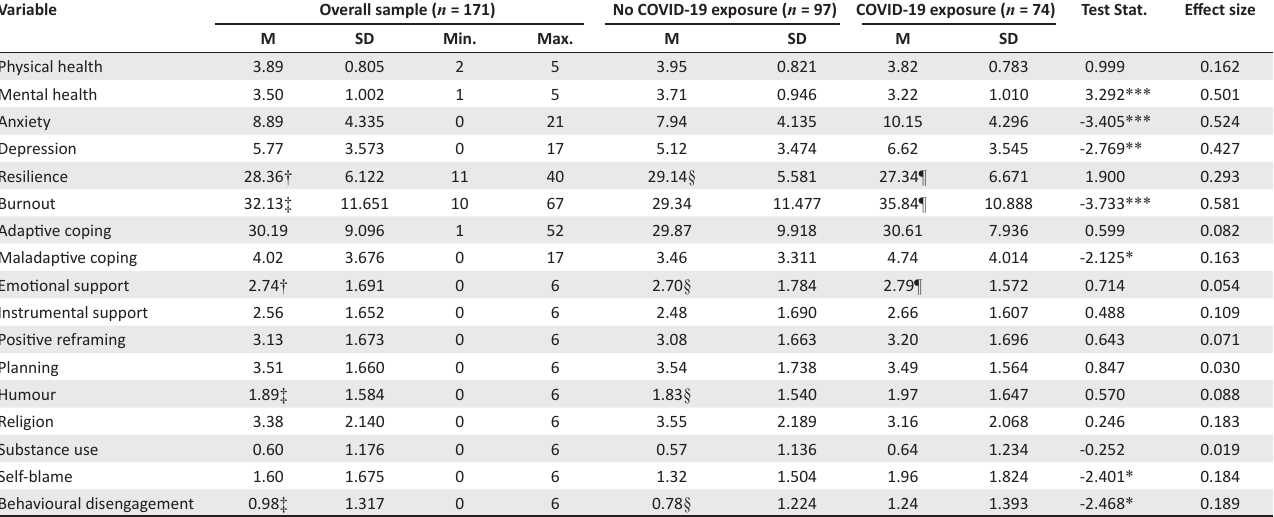
TABLE 2: Descriptive statistics and comparisons between the groups. Variable Overall sample ( n = 171) Test Stat. Effect